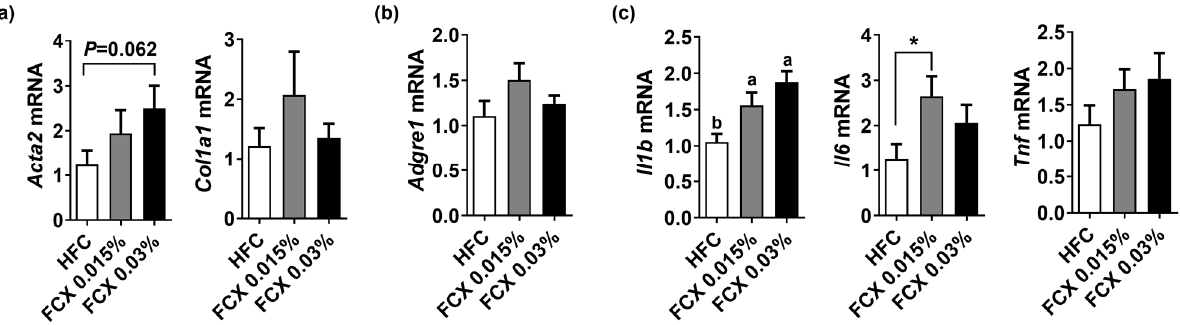
Figure 3. Effect of FCX on the expression of pro-fibrogenic and inflammation genes in the liver of DIO mice fed HFC control, FCX 0.015%, or FCX 0.03% for 12 weeks. Hepatic mRNA levels of ( a ) pro-fibrogenic genes, ( b ) macrophage marker, and ( c ) inflammation genes. n = 9–11 per group. Mean ± SEM. Bars without sharing the same letter are significantly different ( p < 0.05). * p < 0.05 between two